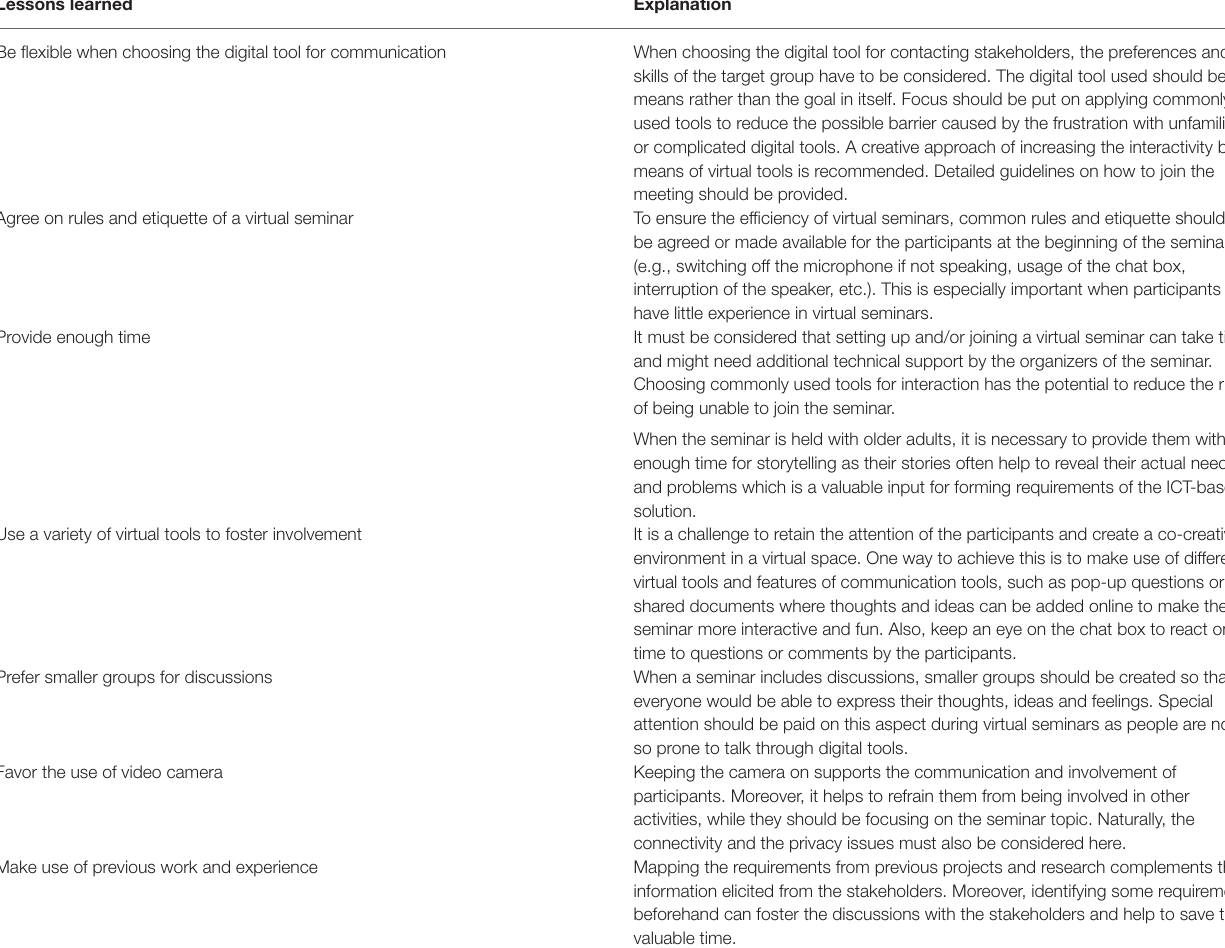
TABLE 2 | Lessons learned from requirements elicitation during COVID-19 restrictions. Lessons learned